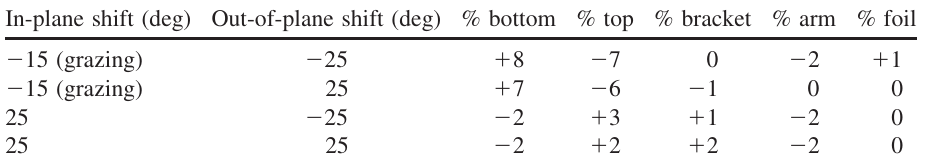
TABLE IV. Loss distribution of electrons for 4th generation foil assembly with shifted out- scattering distributions. The numbers are given as absolute increases or decreases from the results in Table